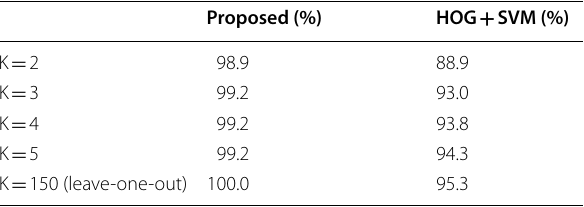
Table 1 Identification accuracy using stratified K-fold cross-validation (the average of 5 trials performed using data shuffled at random